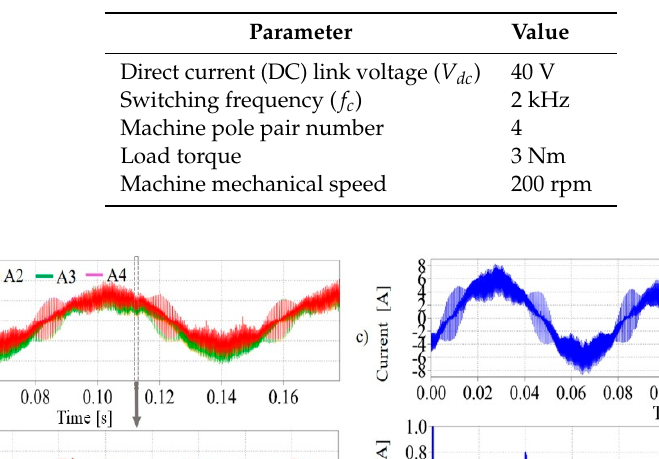
Figure 4. Quadruple three-phase drive system experimental setup. Table 1. Experimental parameters.